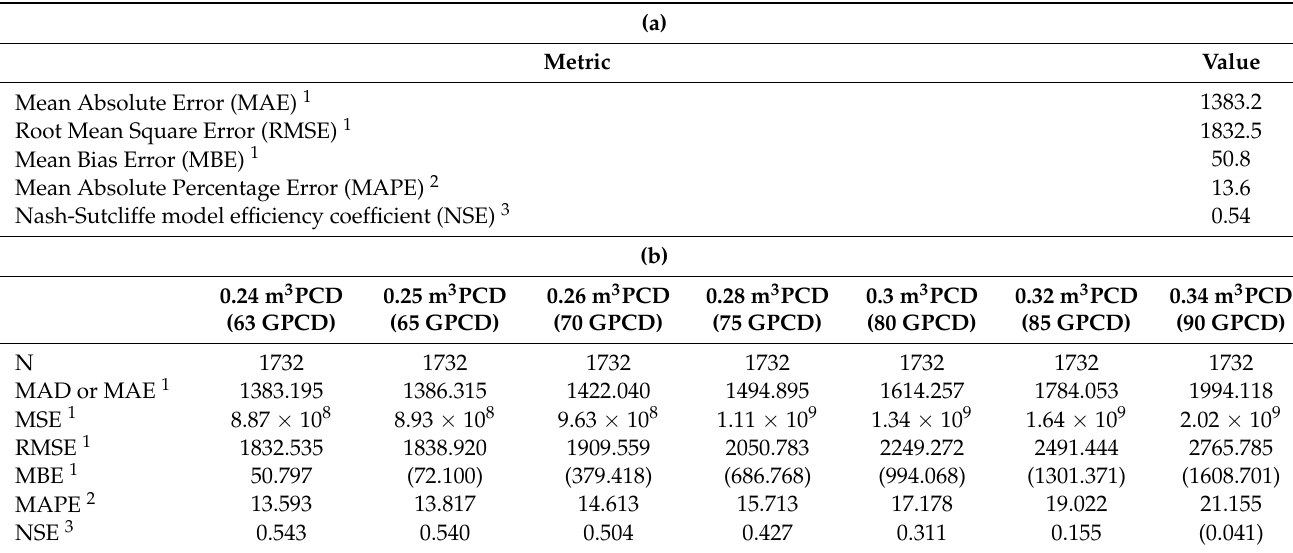
Table 2. Metrics to Measure Predictive Ability of the Model. ( a ) Error Metrics for Dataset. ( b ) Error Metrics while Varying Residential Outdoor Per Capita Demand